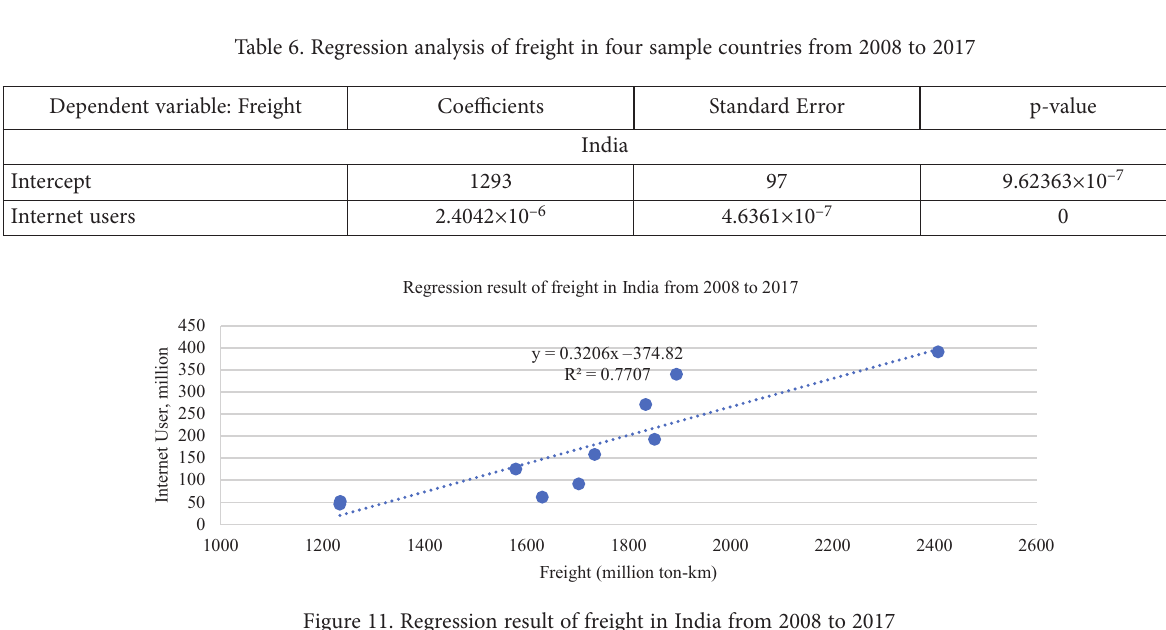
Figure 11. Regression result of freight in India from 2008 to